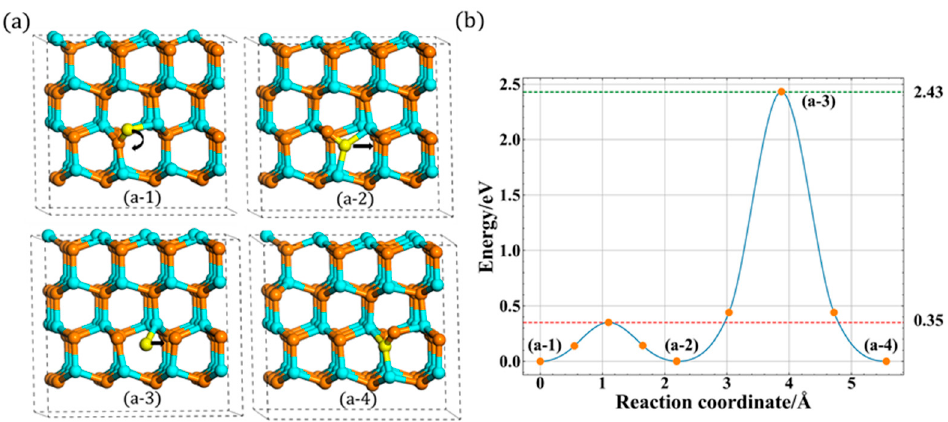
Figure 5. The indirect in-plane migration for A site: ( a ) the process of indirect migration and ( b ) the corresponding energy barrier.